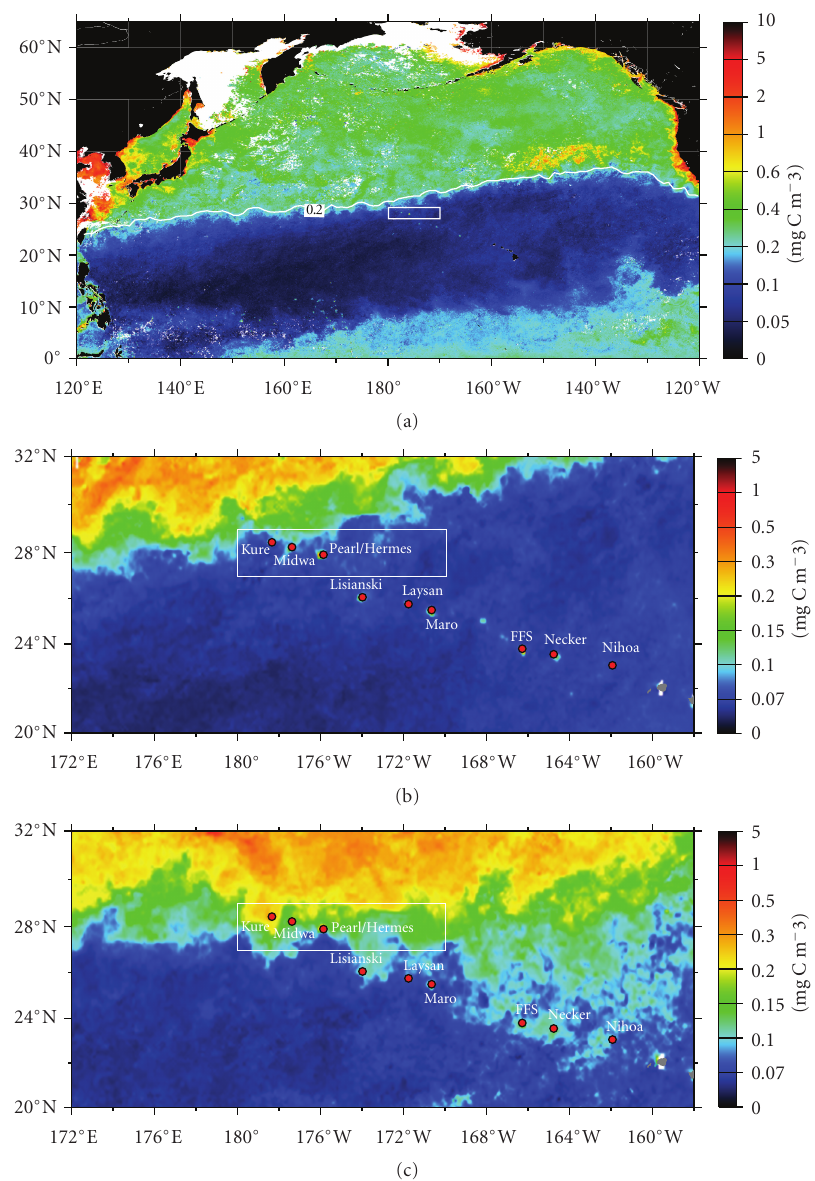
Figure 4: Surface chlorophyll estimated from SeaWiFS ocean color for (a) March 2000 basin-scale, (b) March 2000 where northern atolls remain in low chlorophyll water, and (c) March 2004 where high-chlorophyll waters reach the northern atolls